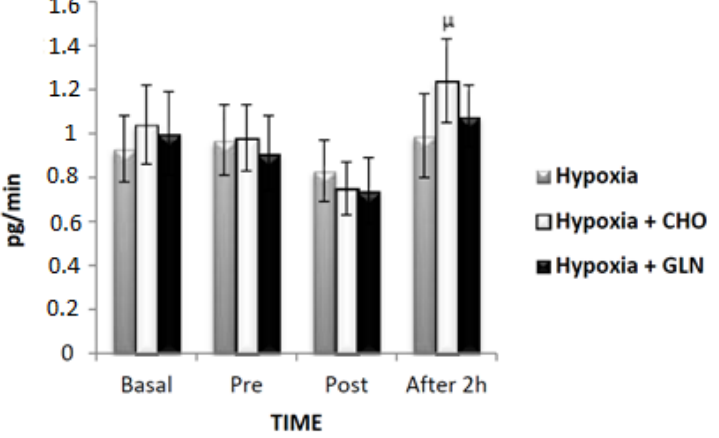
Figure 4. The results of interleukin (IL)-10 secretory (pg/min) was described by mean ± Standard Error (SE). The interaction of group versus time was analyzed by Analysis of Variance (ANOVA) for repeated measures followed by post hoc of Tukey test. The level of significance was set at p < 0.05. n = 15 volunteers. μ statistically significant in relation to post-exercise. Hypoxia + CHO = Hypoxia + carbohydrate and hypoxia + GLN = hypoxia + glutamine.